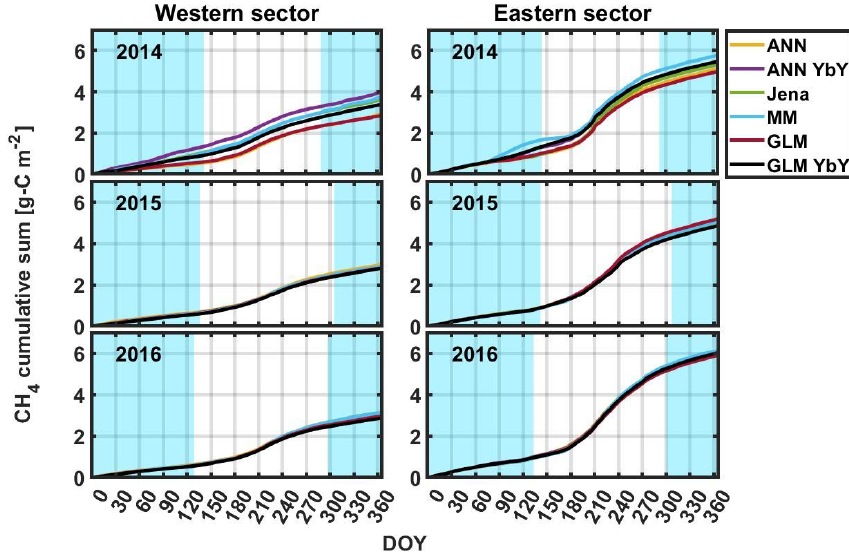
Figure 7. The cumulative sum of CH 4 fluxes for the years 2014–2016 for western and eastern sectors calculated with the different gap-filling methods. ANN – the artificial neural network for all years; ANN YbY – artificial neural network each year separately; Jena – Jena online gap-filling tool; MM – moving mean with 5d moving window; GLM – the general linear model for all years; GLM YbY – the general linear model for each year separately. The shaded light blue area designates the frozen period when peat temperature at 10cm was below 0 ◦ C (see Sect. 2.8 for a detailed description). Table 8. Average annual GPP, NEE, and CH 4 emission from the western and eastern sector in comparison to